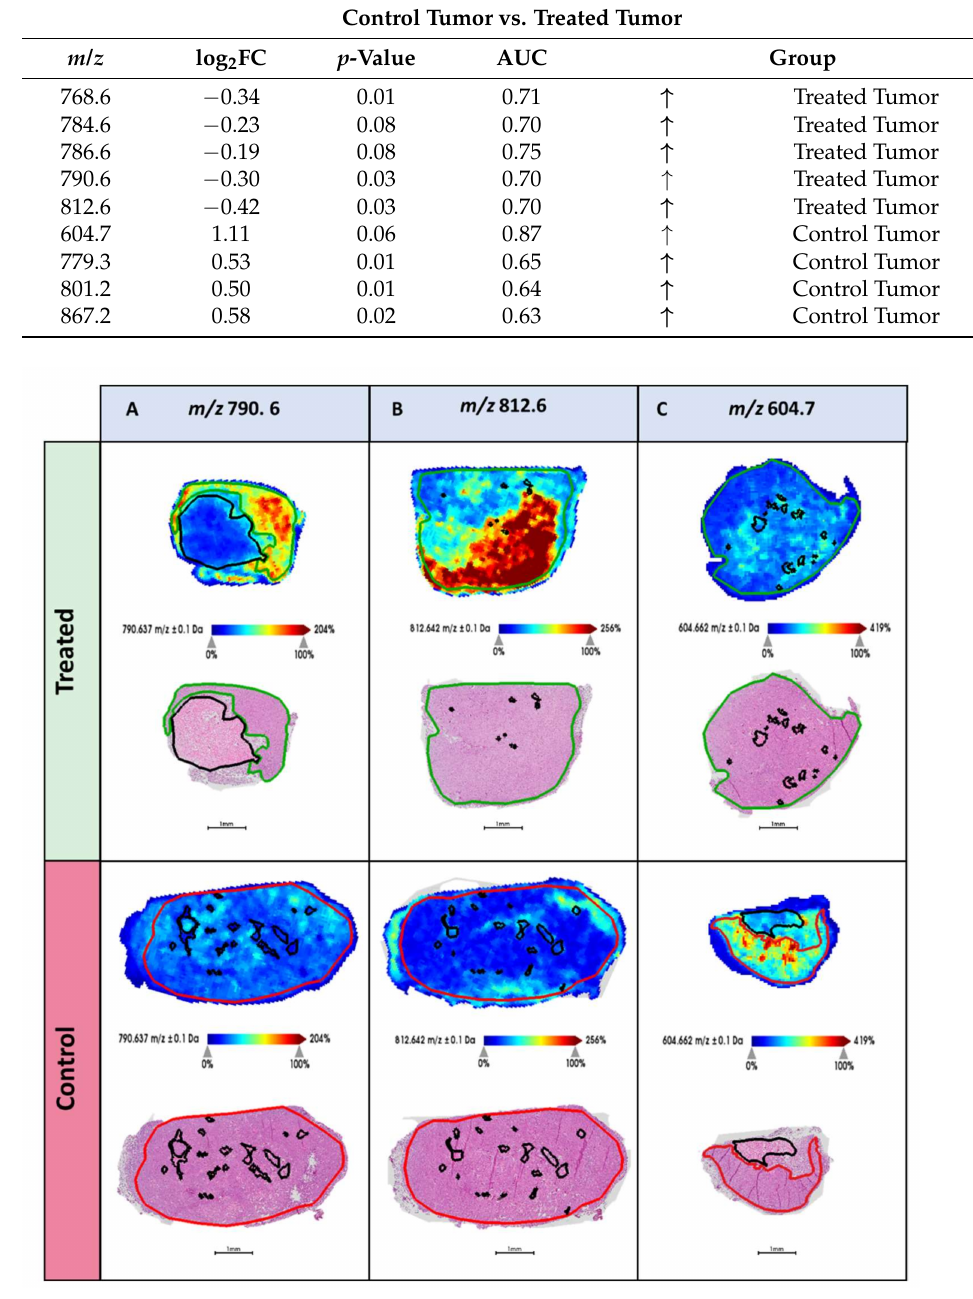
Figure 3. MALDI-MS images highlighting the tissue distribution of ( A ), m/z 790.6, ( B ) m/z 812.6, and ( C ) m/z 604.7 in (top) the treated and (bottom) control xenografts. HES stained images of each tissue section is provided below with the pathologist’s annotation of the tumor regions (green = treated tumor and red = control tumor). Necrotic regions are marked in